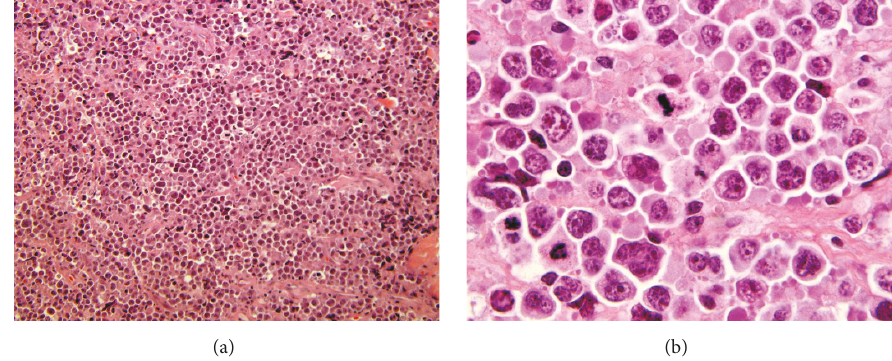
Figure5:The55-year-oldpatient’slymphomafromcase2showedmicroscopicallyamorediffuseinfiltrateoflargecellswithabundantmitotic figures (a,